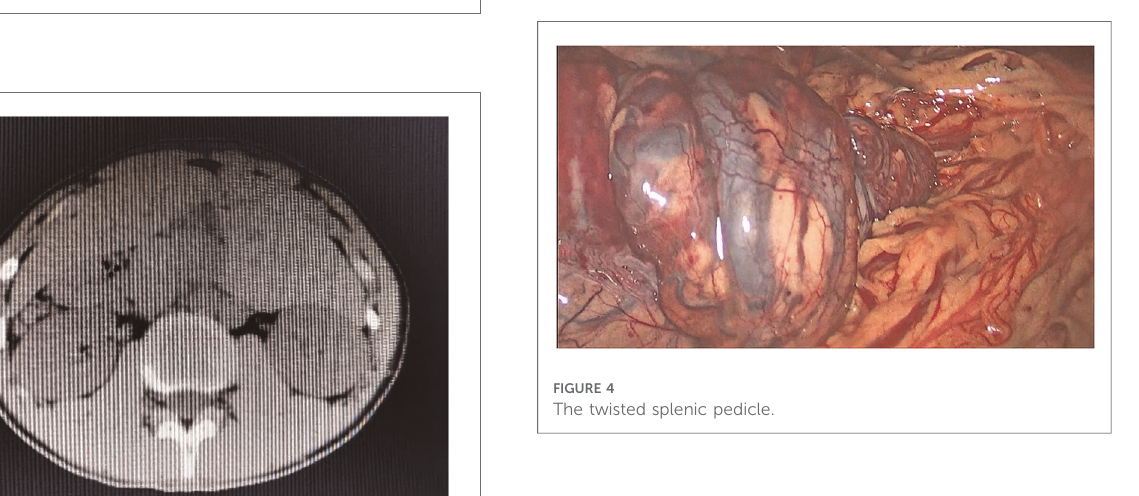
FIGURE 1 Coronal section CT scan of abdomen. Organ inversion, splenomegaly, and intestinal effusion-labeled spleen.